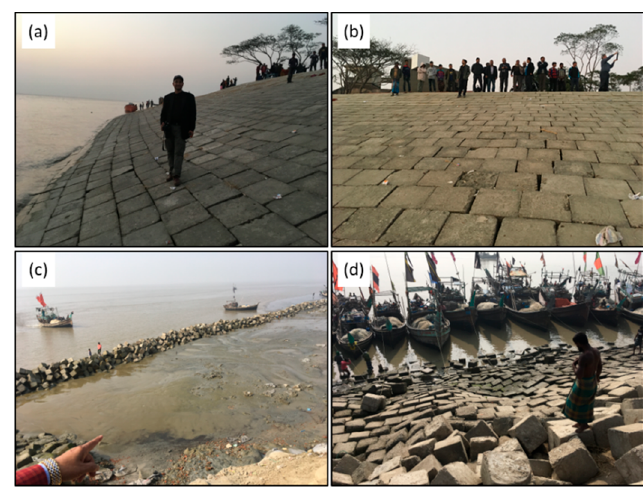
Figure 1. Revetments in Ramgati Upazila: ( a , b ) at Char Alexander, constructed 2015 – 2017; ( c , d ) at Ramgati Ghat, construction started in 2018 and ongoing at time of photos taken in January 2018 (photos by T. Crawford).